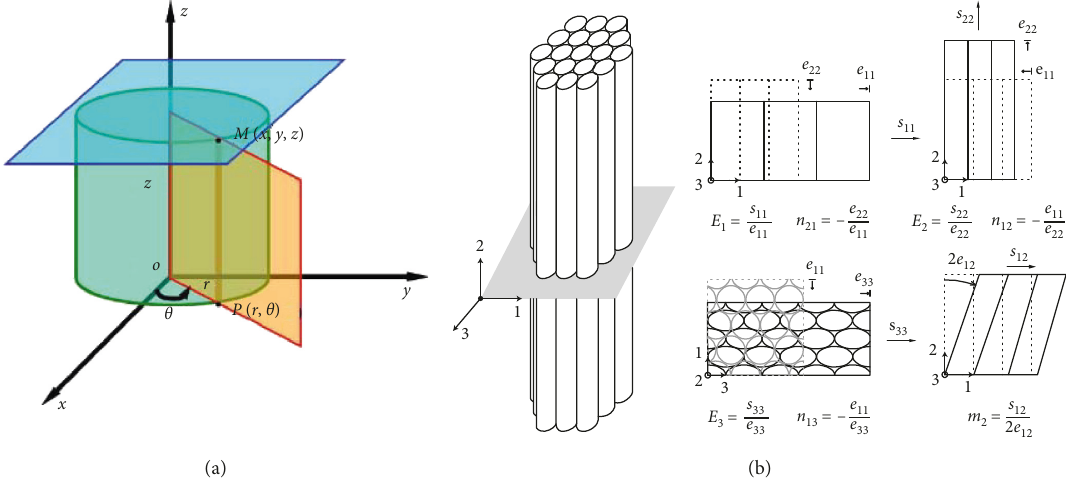
Figure 5: Simplified cable model. (a) Cylindrical coordinate system. (b) Fiber-reinforced model.